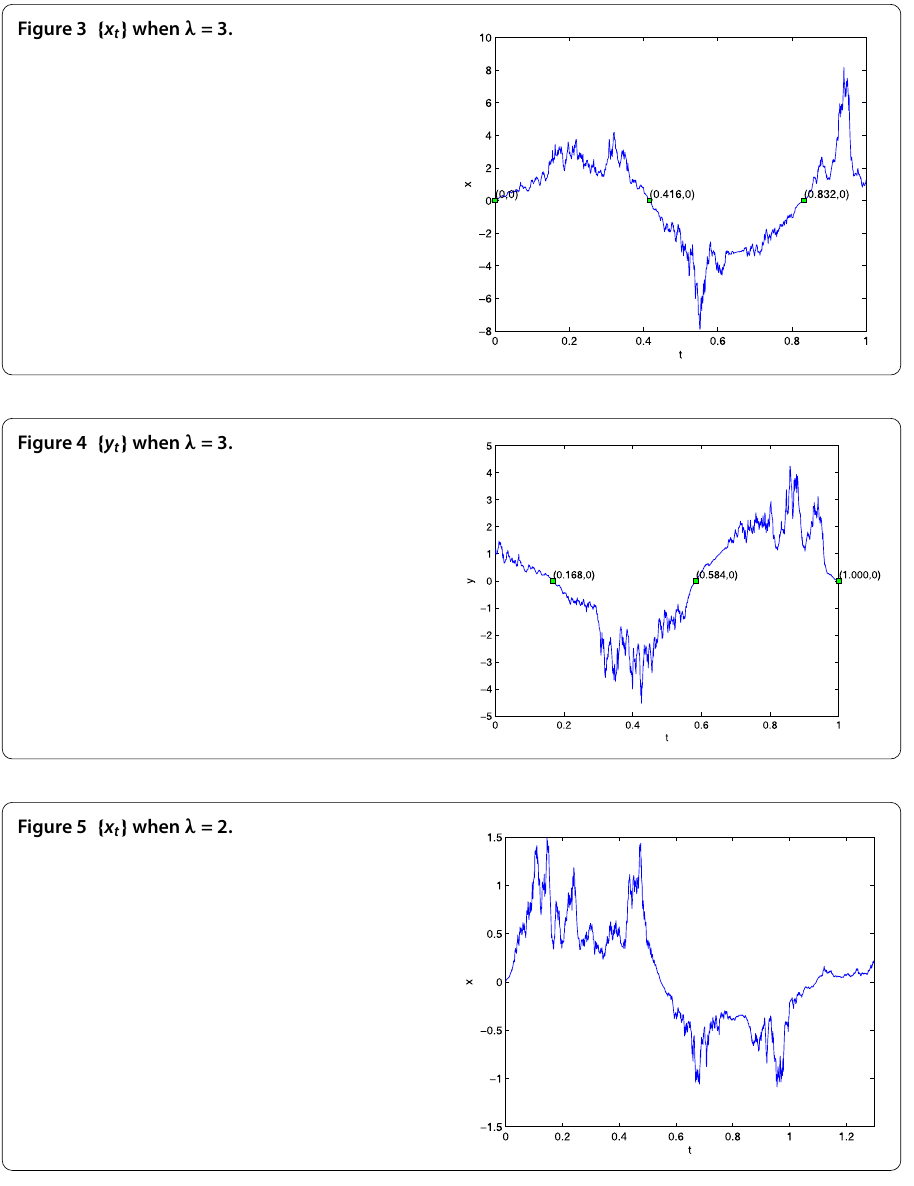
Figure 3 { x t } when λ = 3.